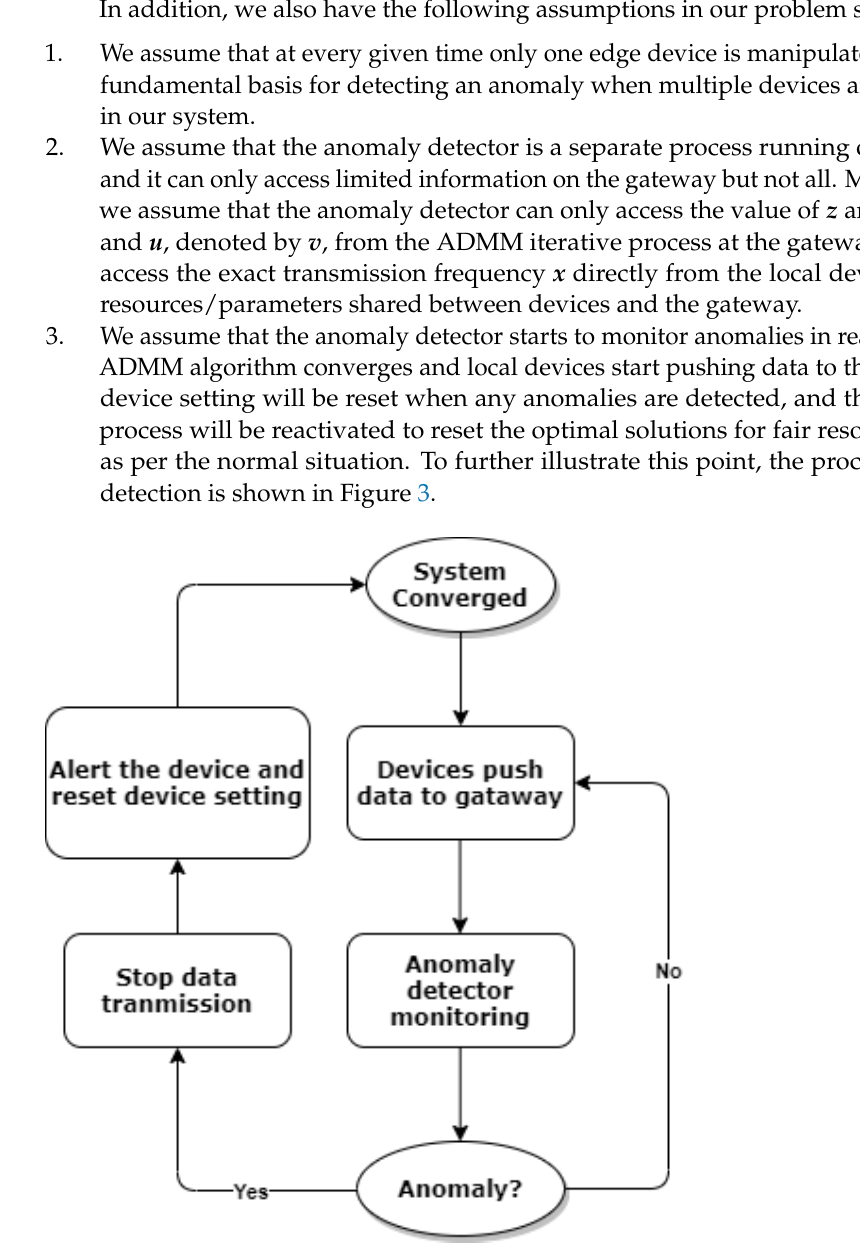
Figure 3. Anomaly detection and response